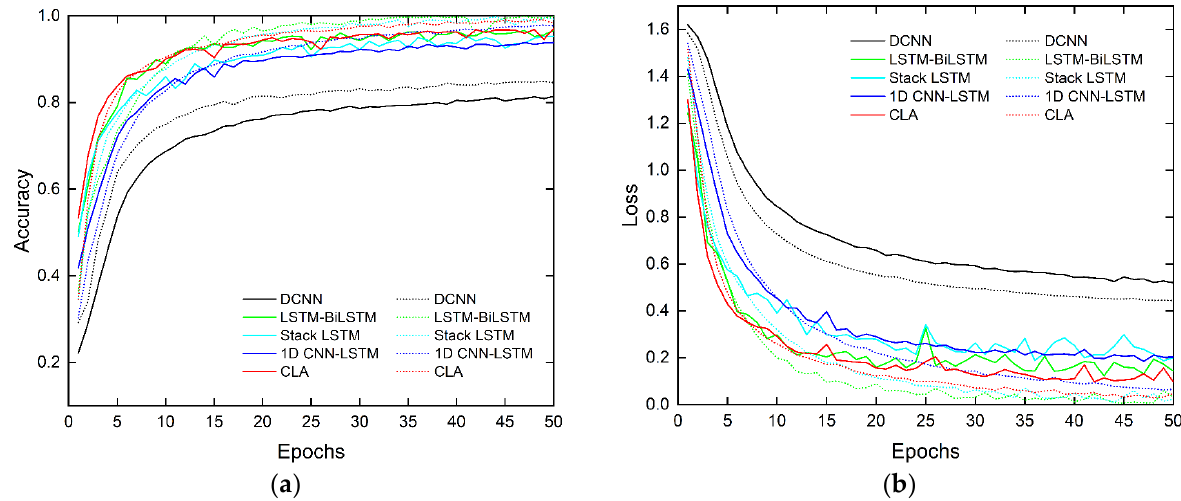
Figure 15. ( a ) Curves of training and validating accuracy varying with the number of epochs for the literature networks; ( b ) curves of training and validating loss varying with the number of epochs for the literature networks. (The solid line represents the validating curve; the dotted line represents the training curve) .